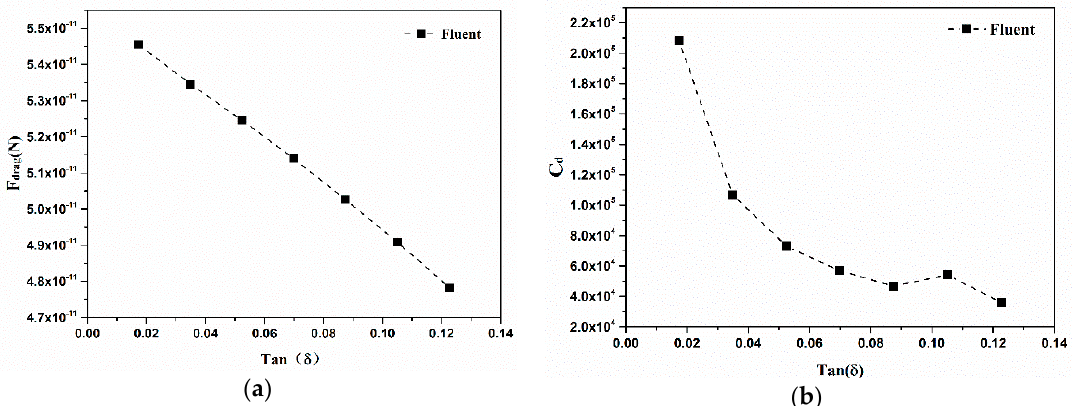
Figure 5. The drag force and drag coefficient versus semi-cone angle ranging from 1° to 7°.